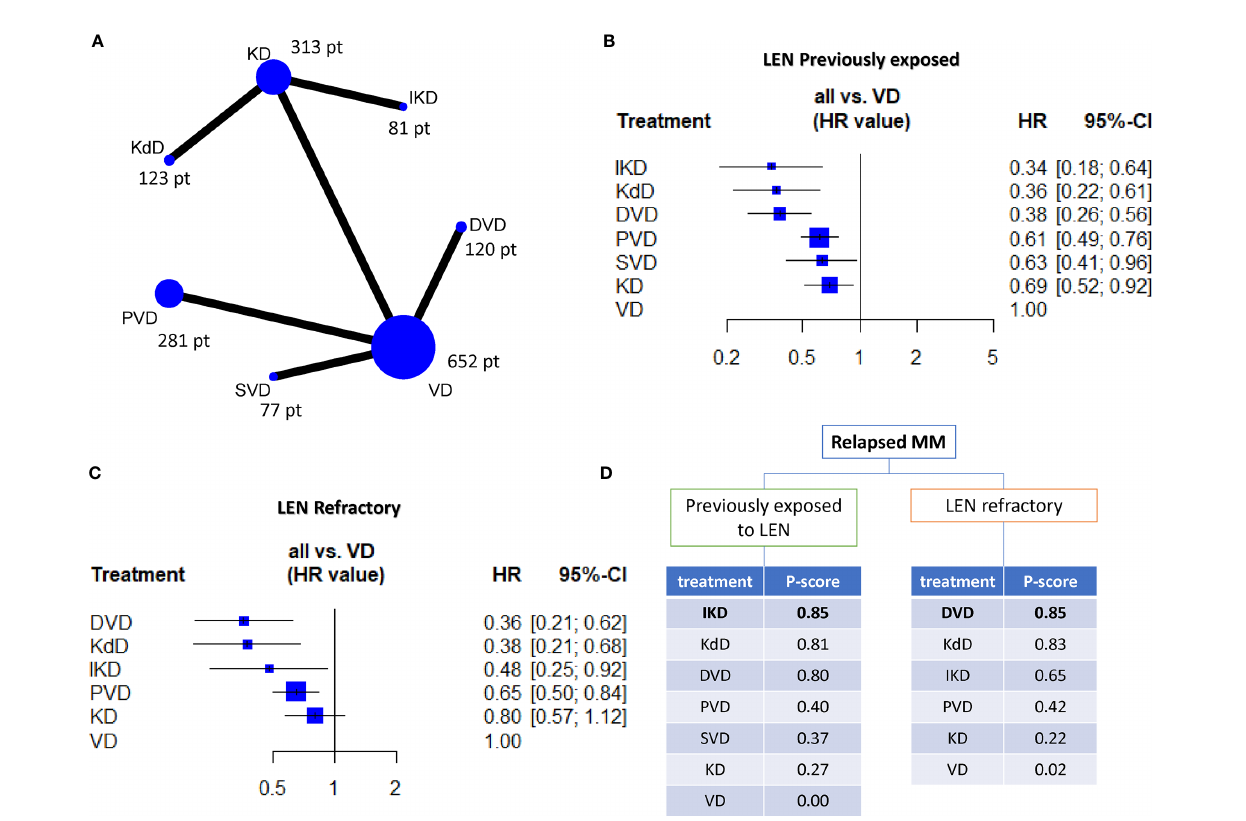
FIGURE 1 | (A) Network plot showing all the direct comparisons and the number of patients included in each node (i.e. the total number of patients receiving the treatment indicated in the node). (B, C) forest-plots indicating the ef fi cacy of each regimen (in terms of hazards ratio (HR) and 95% con fi dence intervals) by using VD as comparator arms. (D) Ranking charts of all the evaluated regimens based on the P-score and grouped according to previous exposition or resistance to lenalidomide. VD, bortezomib-dexamethasone; DVD, daratumumab-VD; SVD, selinexor-VD; PVD, pomalidomide-VD; KD, car fi lzomib-dexamethasone; KdD, daratumumab-KD; IKD,